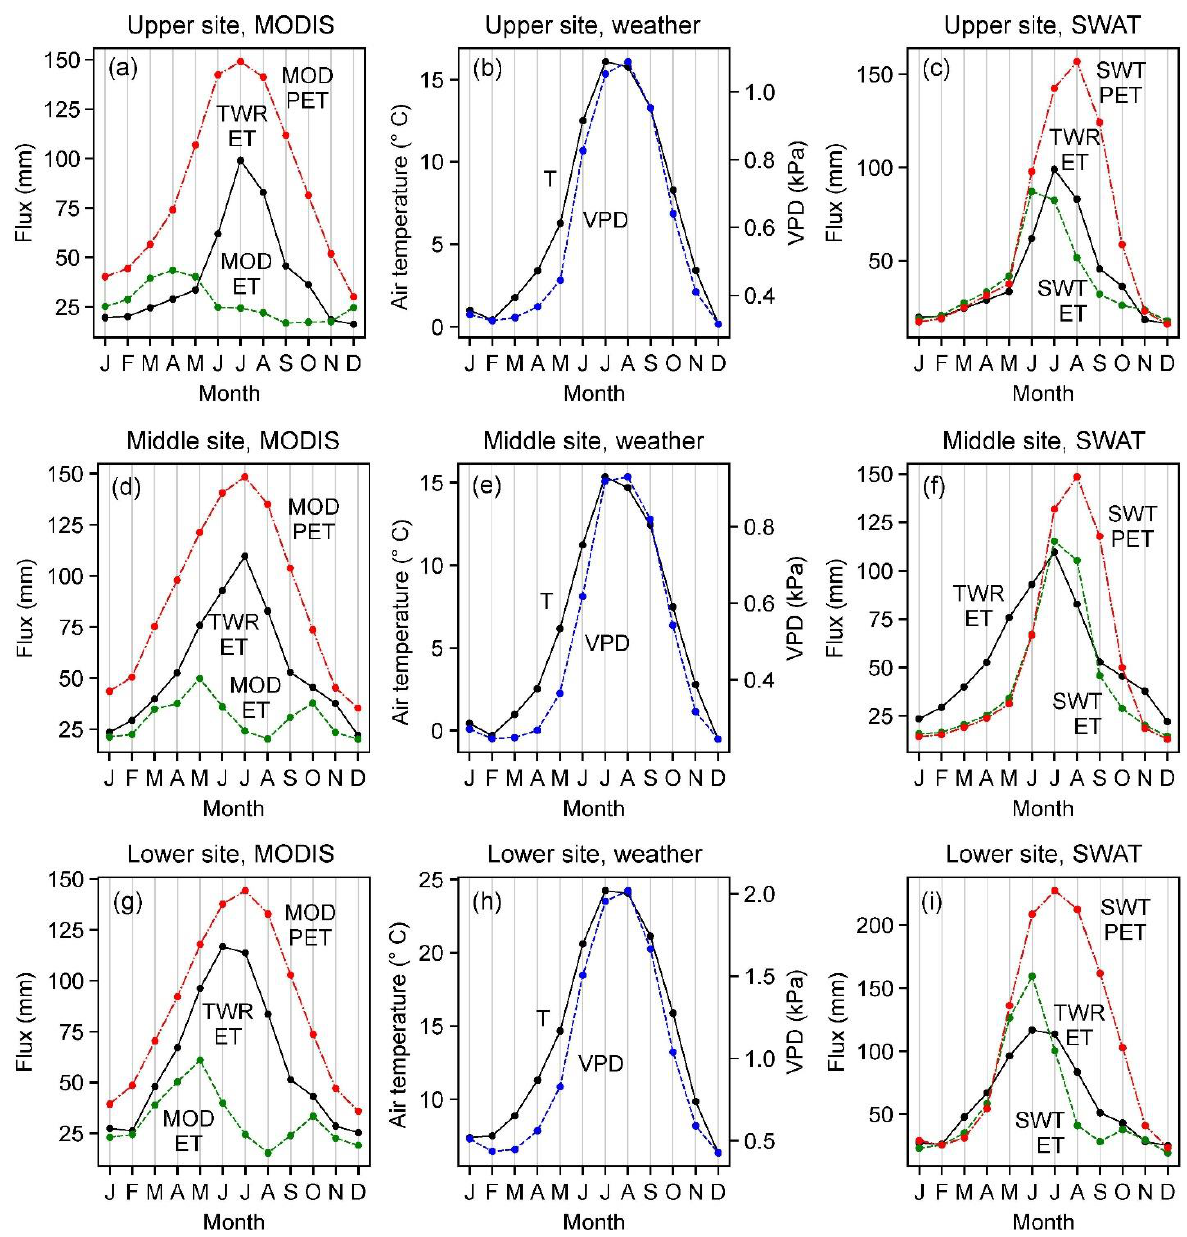
Figure 5. Monthly averages in air temperature (T), vapor pressure deficit (VPD), ET, and potential ET (PET) at the ( a – c ) upper site, ( d – f ) middle site, and ( g – i ) lower site. TWR = flux tower observation, MOD = MODIS value, SWT = SWAT value. MODIS PET (MOD PET) values have been multipled by 0.5.